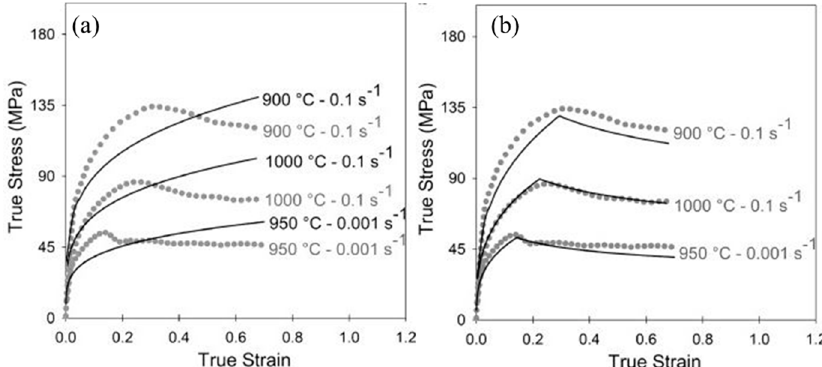
Figure 38. Comparison of the experimental and calculated values of true stress–strain based on ( a ) the existing Zerilli–Armstrong (ZA) model and ( b ) the modified ZA model [230] .